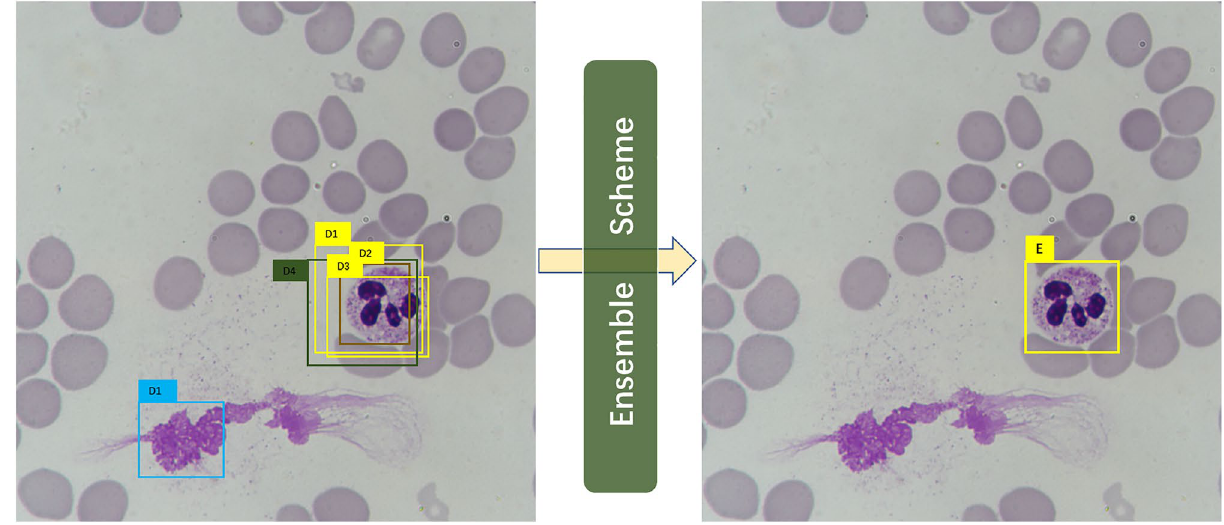
Figure 1. An illustrative example of the ensemble scheme. The raw detections are given in the left image, and the right image is the result after